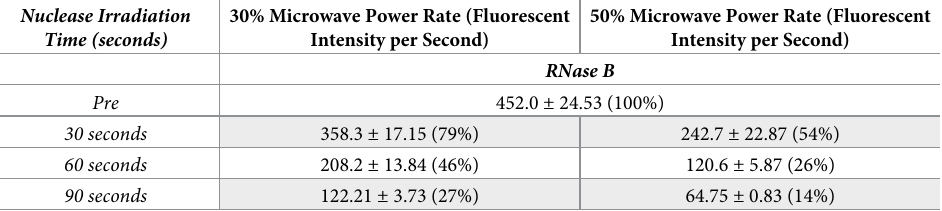
Table 2. RNase B rates and percentage still active post Lyse-It at 30% and 50% power, varying the time. (Pre = no